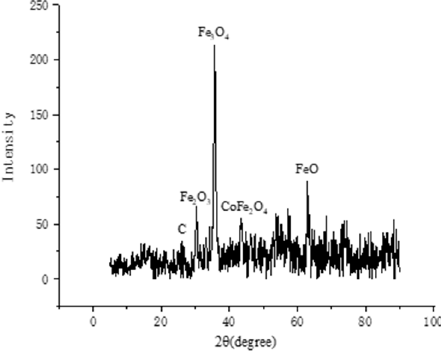
Figure 3. XRD spectra of Co-nZVI/GAC.